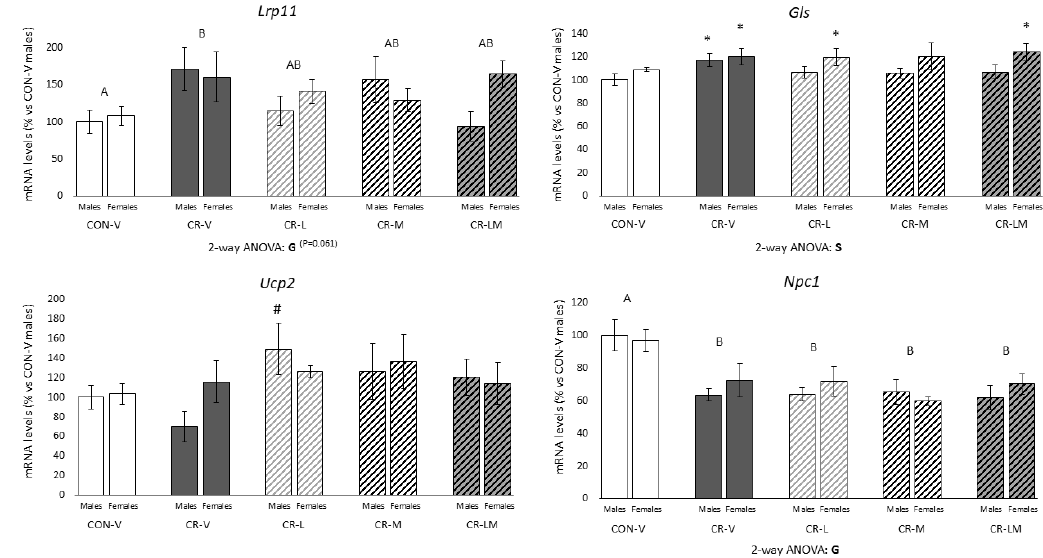
Figure 4. Expression levels of selected genes in peripheral blood mononuclear cells (PBMC) of 25-day-old male and female offspring of control (CON) and 25% gestational calorie-restricted (CR) dams. mRNA levels are expressed as a percentage of the value of CON-V male rats. Data are means ± s.e.m ( n = 6–9). Statistics: Two-way ANOVA was performed to assess the effects of sex and group (CON-V, CR-V, CR-L, CR-M, and CR-LM), followed by a least significant difference (LSD) post-hoc test. Mann–Whitney U test was used for single comparisons between groups. Symbols: S, effect of sex; G, effect of group; A (cid:54) = B ( p < 0.05, two-way ANOVA); *, different from their respective CON-V group; #, different from their respective CR-V group ( p < 0.05, Mann–Whitney U test). Abbreviations: vehicle (V), leptin (L), myo-inositol (M), leptin and myo-inositol